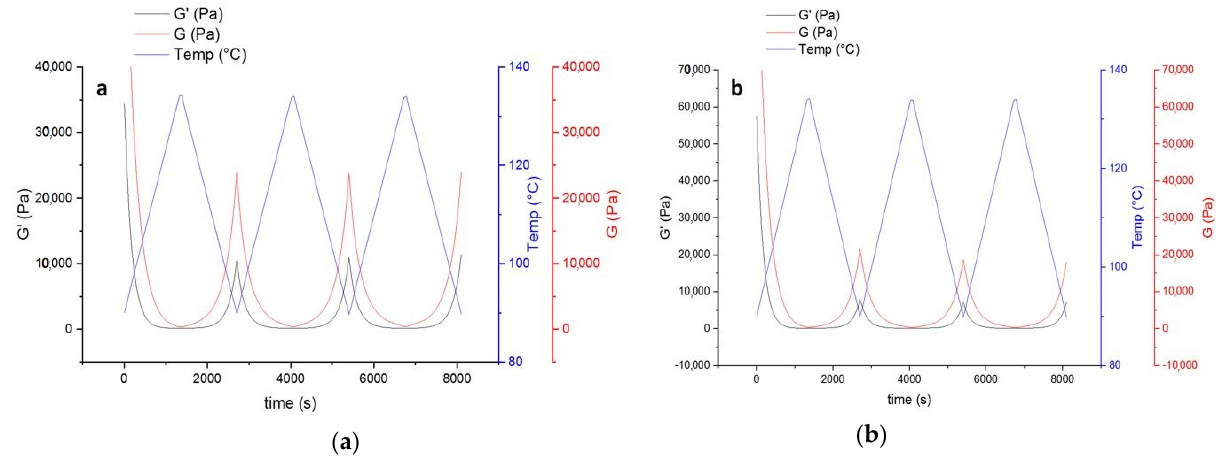
Figure 7. The thermo-reversible behavior of uncured powder samples containing HA based on storage and lost modulus. ( a ) Contains 4% wt. HA, and ( b ) 9% wt.